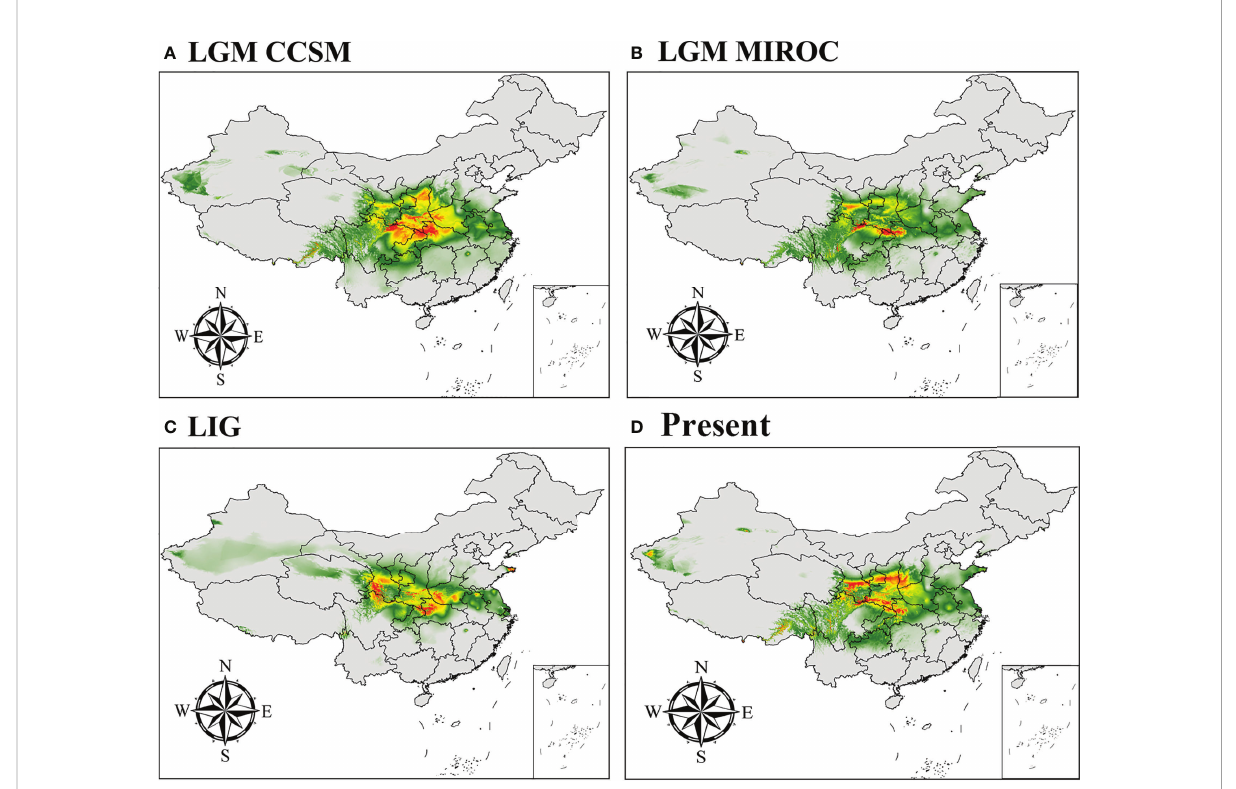
FIGURE 5 Potential distribution for P . rockii subsp. rockii during different periods predicted by the MaxEnt model based on optimized parameters. The potential distribution of P . rockii subsp. rockii was divided into four grades by the natural breaks method. Gray, green, yellow, and red areas represent not suitable, marginally suitable, moderately suitable, and highly suitable areas,